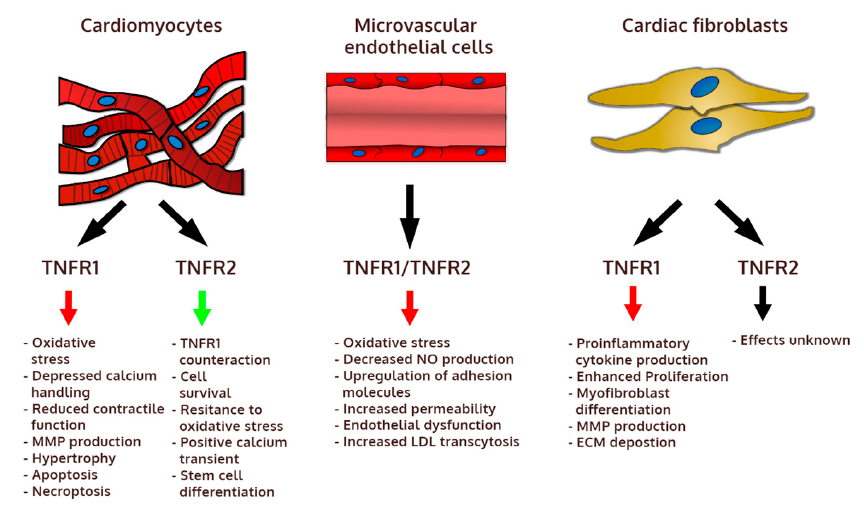
Figure 2. Biological effects mediated by TNFR1 and TNFR2 in main cellular components of the heart. ECM: extracellular matrix, LDL: low-density lipoprotein, MMP: matrix metalloproteinase, NO: nitric oxide.